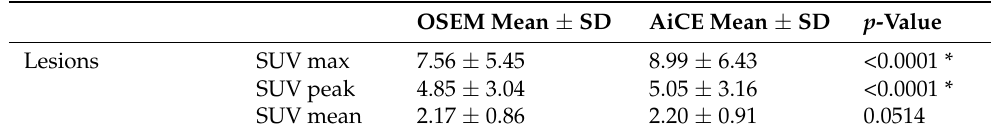
Table 4. SUVs in pathological lesions ( n = 80).